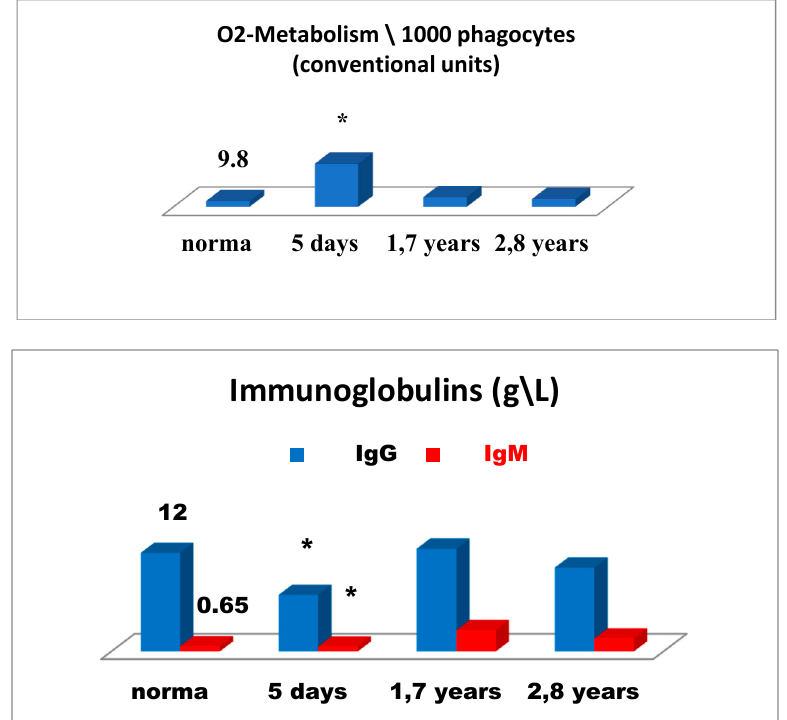
Figure 7. Oxygen metabolism of phagocytes and the level of immunoglobulins G and M in patient 2 in the early and late periods after cryodestruction of pancreatic cancer. Legend: * significance of differences.